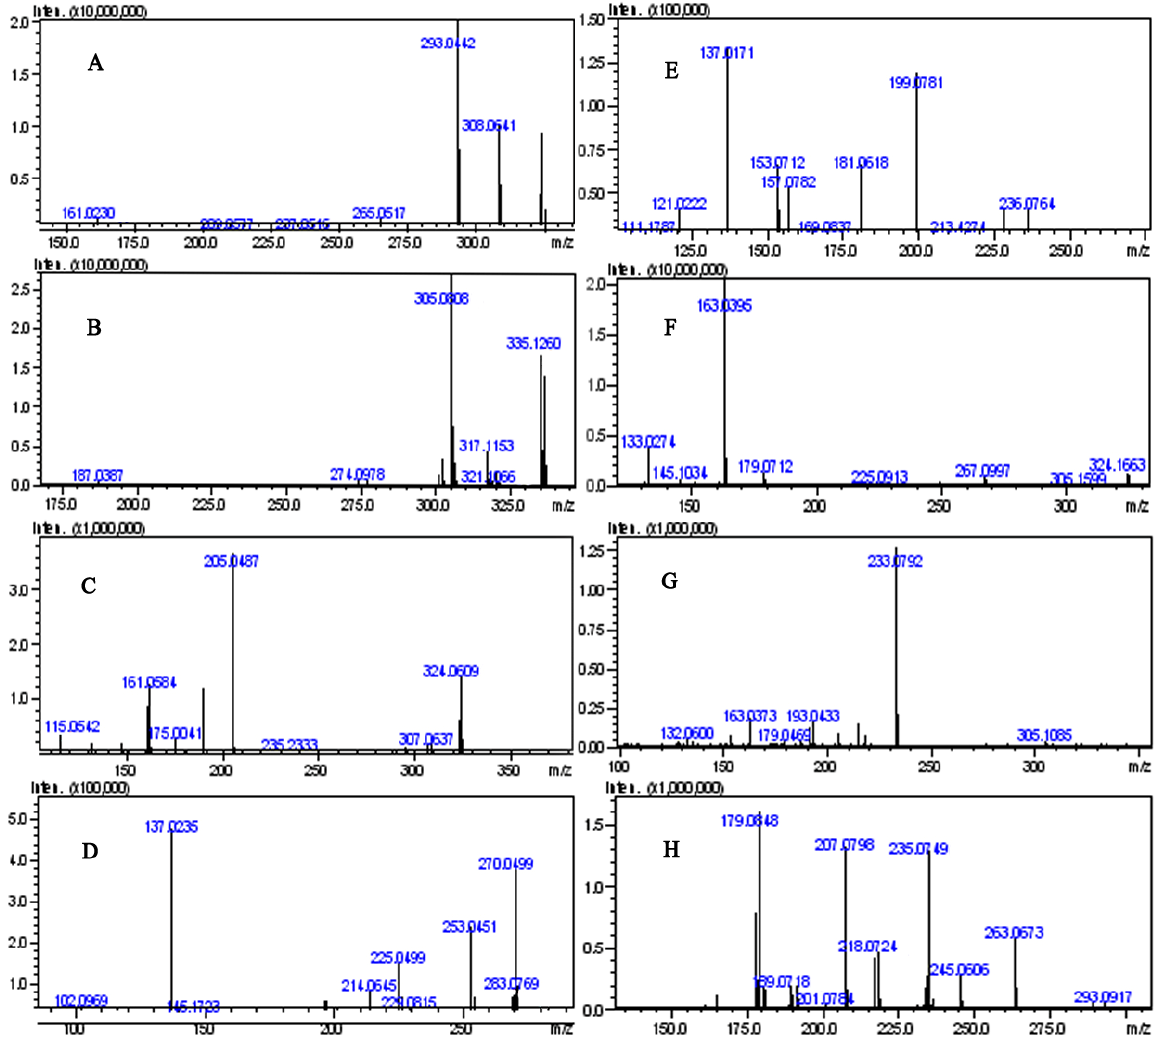
Figure 4. ESI-MS/MS of selected ions from the chromatograms presented in Figure 2: ( A ) m/z 323.0909, compound 25 , 3',4'-dimethoxy(2",3":7,8)furanoflavone; ( B ) m/z 335.1270, compound 40 , karanjachromene; ( C ) m/z 339.1128, compound 11 , β ,2',5'-trimethoxyfurano [4'',5'':3',4']-chalcone; ( D ) m/z 285.0755, compound 1 , ( − )-maackiain; ( E ) m/z 255.0642, compound 3 , 7,4'-dihydroxyisoflavone; ( F ) m/z 323.1617, compound 41 , isoderricin A; ( G ) m/z 337.1428, compound 33 , 7-methoxyl-8-(3''-hydroxy-3''-methyl-1''-butenyl)-flavone; ( H ) m/z 291.0649, compound 16 ,